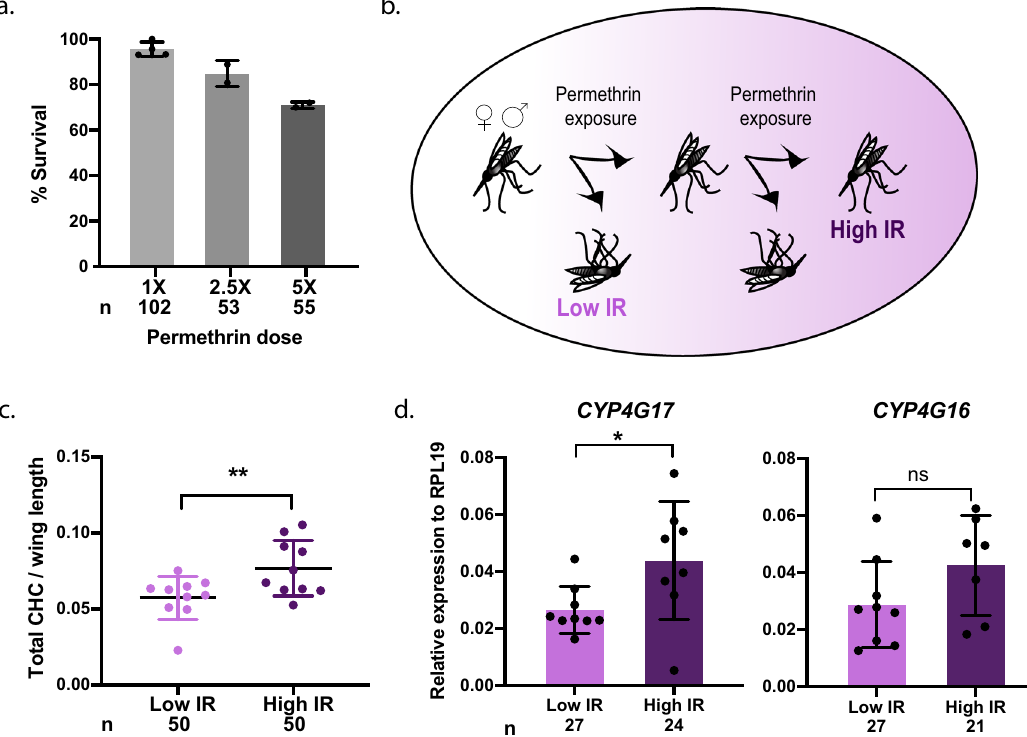
Fig. 3 CHC levels are correlated with insecticide resistance intensity in fi eld-derived A. coluzzii . a Insecticide resistance bioassays using 1×, 2.5×, or 5× permethrin-impregnated papers show high insecticide resistance in A. coluzzii adults collected as larvae from VK5 breeding sites. b Scheme of experimental design showing how mosquitoes from larval collections were categorized as Low IR or High IR based on their survival to two sequential permethrin exposures. c High IR mosquitoes show higher abundance of CHCs compared to Low IR mosquitoes (Generalized Linear Model, p = 0.0083) after normalizing for wing length and accounting for sex within the model ( p = 0.2651). Mean and SD are shown. d High IR females also show higher transcript abundance of CYP4G17 (unpaired t -test, p = 0.0346), but not CYP4G16 (unpaired t -test, p > 0.05) by qRT-PCR. Bars represent mean and SD; n represents total number of We next tested whether CHC abundance was correlated with longer when exposed to the same doses (Supplementary Fig. 3a). IR intensity in the same population using age-matched A. coluzzii mosquitoes collected from larval breeding sites. We fi rst separated mosquitoes according to their IR intensity (Low or High IR) based on their survival to two consecutive permethrin exposures. were observed (Supplementary Table 2). We detected a 1.33-fold We classi fi ed as Low IR mosquitoes those who died after a single exposure to permethrin, while High IR mosquitoes were those who also survived a second exposure (Fig. 3b). Permethrin doses (Generalized Linear Model, p = 0.0083) (Fig. 3c). High IR used were different in males and females, as females survived mosquitoes were larger ( Supplementary Fig. 3c), but we